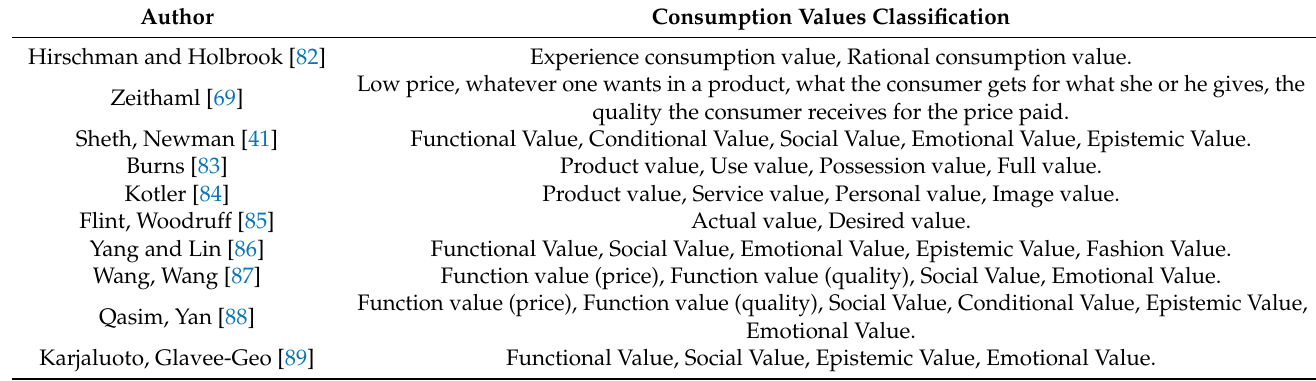
Figure 1. The five values influencing consumer choice. Source: Sheth, Newman [41] (p. 160). Table 1. Consumption value